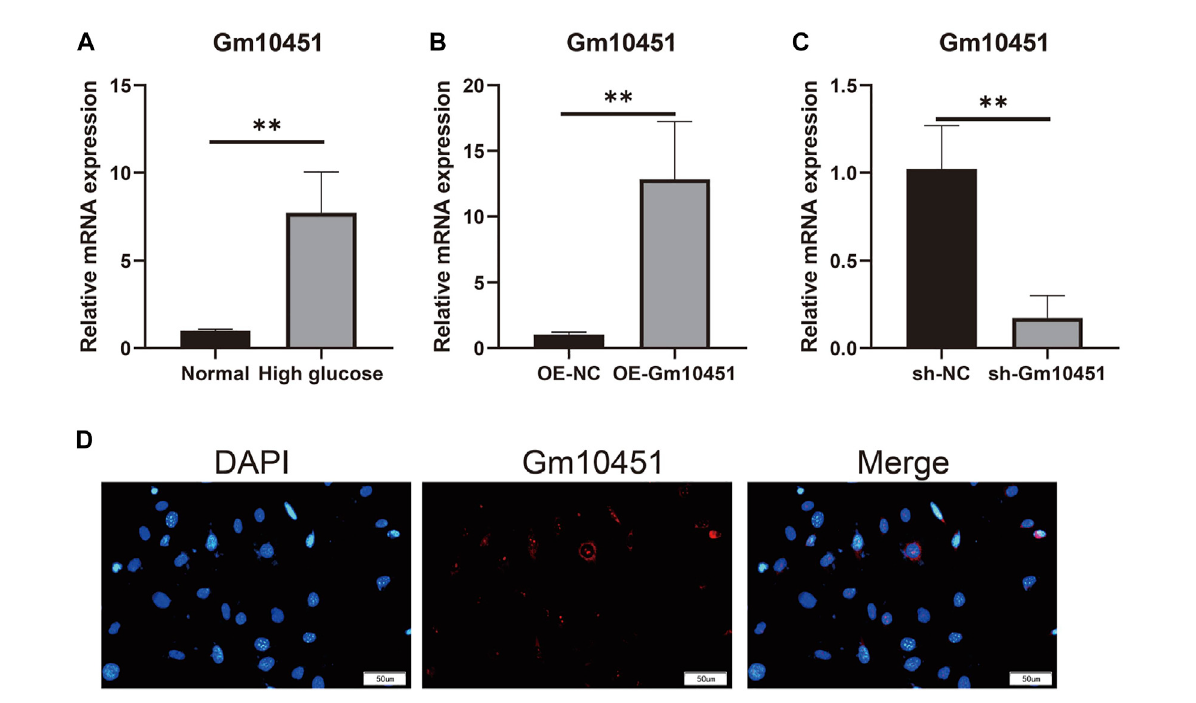
FIGURE 1 Gm10451 expression levels of MIN6 cells in the hyperglycemic environment. (A) Determination on Gm10451 expression in MIN6 cells under hyperglycemia by qPCR assay. (B) Determination on the Gm10451 expression level in Gm10451 over-expressed MIN6 cells by qPCR assay. (C) Determination on the Gm10451 expression level in Gm10451-interfered MIN6 cells by qPCR assay. (D) Gm10451s localization in MIN6 cells was pinpointed by FISH test. N = 3. **, p <